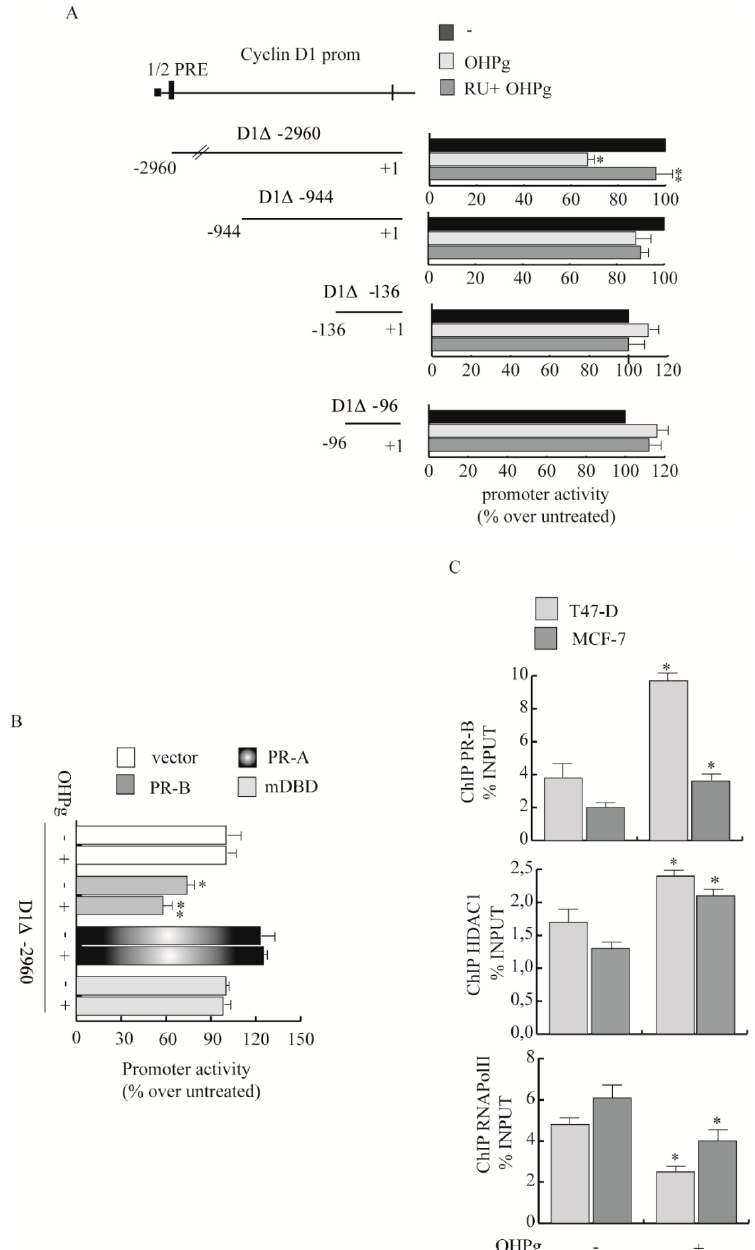
Figure 4. Effects of OHPg/PR-B on CD1 transcriptional activity. ( A ) Left panel: Diagram of the different CD1 gene promoter deletion constructs. Right panel: MCF-7 cells were transiently transfected, treated for 24 h with vehicle, 10 nM OHPg and 1µM RU 486, as indicated. Columns refer to three independent experiments expressed as fold change over vehicle, which was assumed to be 1; bars SD; * p ≤ 0.05 vs. vehicle. ** p ≤ 0.05 vs. OHPg. ( B ) MDA-MB-231 cells were co-transfected with vector control, D1 ∆ -2960 and PR-B or PR-A or DNA binding domain (mDBD) expression vectors, then treated as indicated; bars, SD; * p ≤ 0.05 vs. vector. ** p ≤ 0.05 vs. vehicle PR-B. ( C ) Chromatin Immunoprecipitation (ChIP)-qPCR. T47-D and MCF-7 cells treated with vehicle or OHPg for 6h. Protein-DNA complexes were immune-precipitated with antibodies indicated. Columns are the mean of three independent experiments. Bars, SD; * p ≤ 0.05 vs. vehicle.